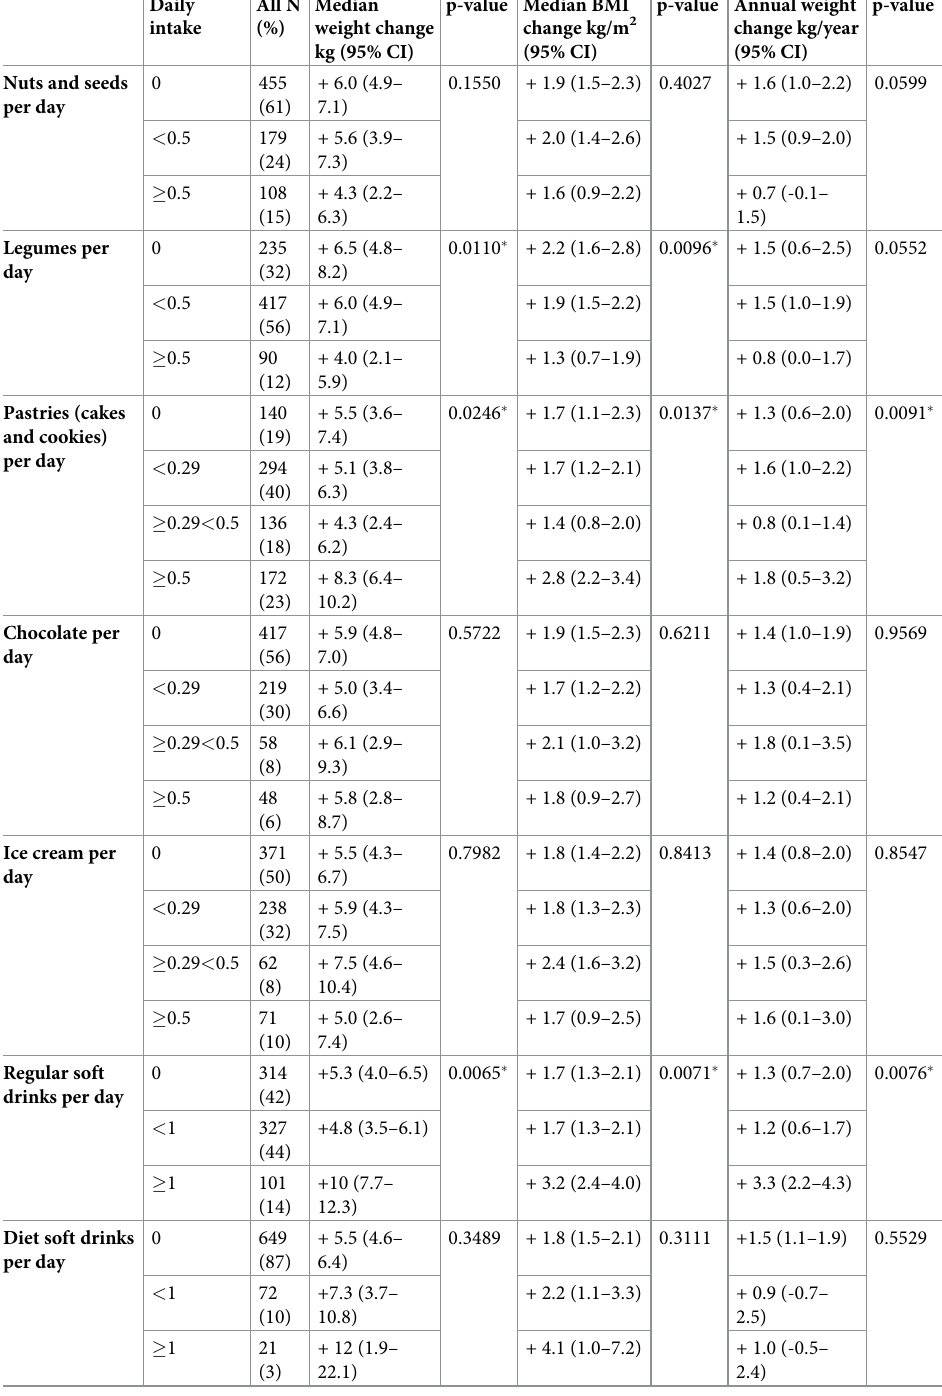
Table 5. Change in median weight, body mass index (BMI) and annual weight between admission and study fol- low-up in relation to food group intake (food frequency